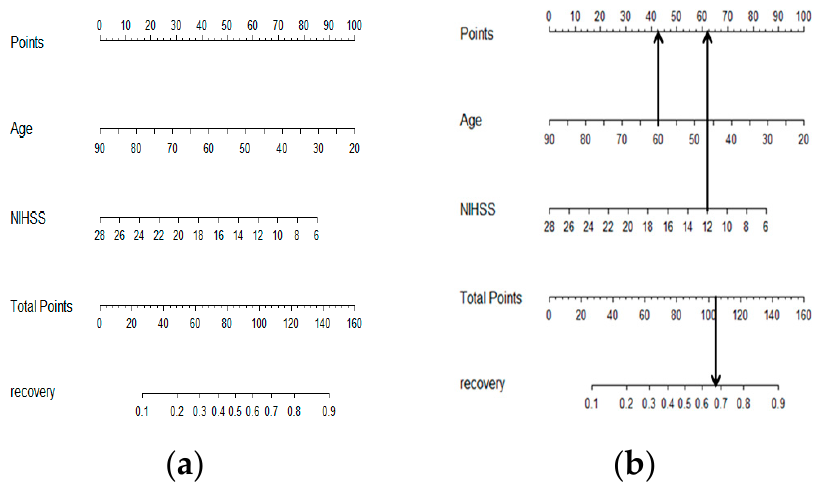
Figure 3. ( a ) Nomogram for functional recovery probability after intravenous thrombolysis. ( b ) Nomogram application of recovery probability before thrombolysis. A line was drawn straight upward with an up arrow to obtain the points for the variables. For example, a patient aged 60 years (43 points) had an NIHSS score of 12 (62 points). The total point score was the sum of age and NIHSS scores with 105. Drawing a straight line downward from total points 105 to the lowest line then corresponds to an estimated recovery probability of